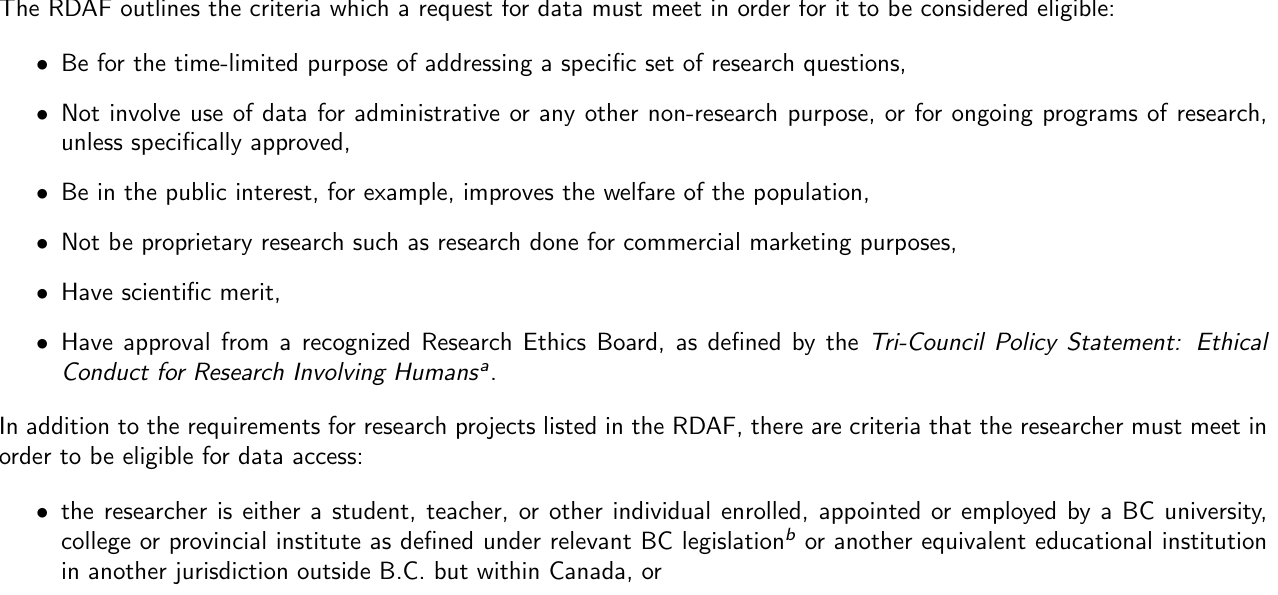
Figure 1: The Research Data Access Framework